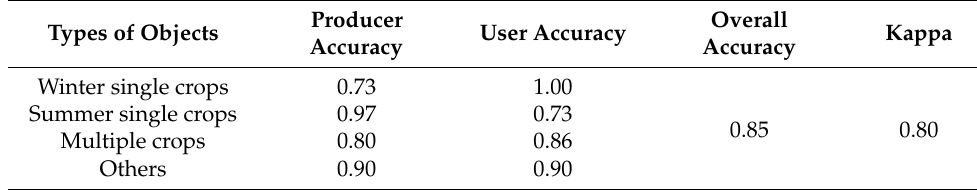
Table 6. Accuracy of remote sensing mapping of crops.